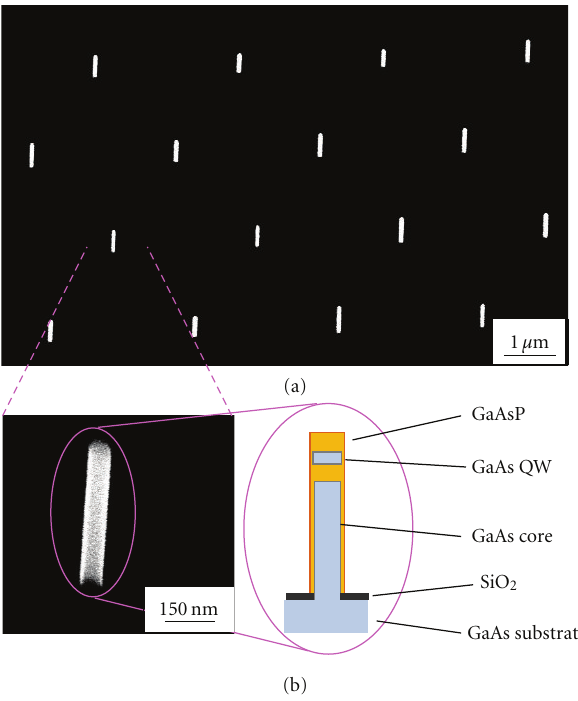
Figure 14: SEM images of heterostructure NWs with GaAs QW buried in GaAsP and schematic cross-sectional structure of NW containing GaAs QW. SEM image at lower left is enlarged view of NW